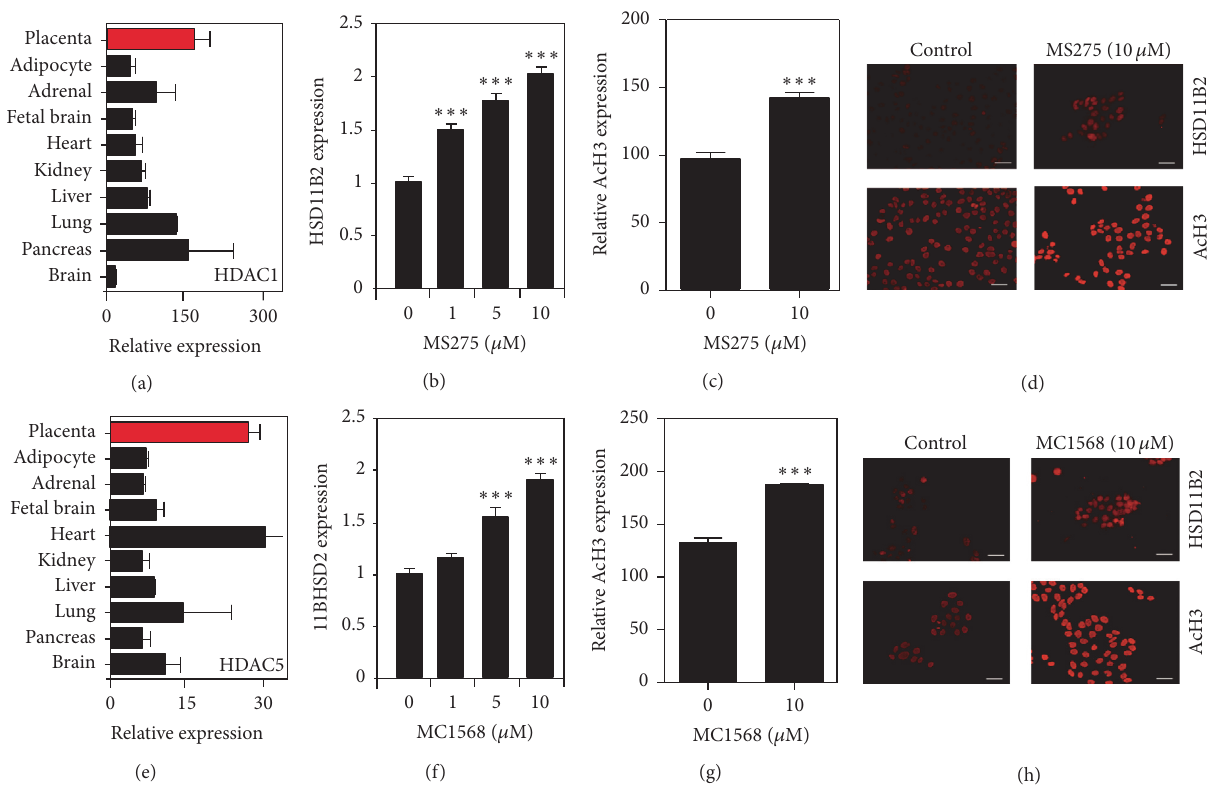
Figure 3: Class-specific HDACs on 11 𝛽 -HSD2 regulation in the placenta. (a) Expression data from the BioGPS database showing the relative expression of class I HDAC, HDAC 1 in the placenta (red) relative to multiple human tissues and fetal brain. Graphical representation of (b) 11 𝛽 -HSD2 and (c) AcH3 expression in JEG-3 cells treated with 0–10 𝜇 M of class I HDAC inhibitor MS275 for 24 h. (d) Representative photomicrographs of JEG-3 cells immunocytochemically stained for 11 𝛽 -HSD2 and AcH3 after treatment with (0–10 𝜇 M) MS275 for 24 h. (e) Expression data from the BioGPS database showing the relative expression of class II HDAC, HDAC 5 in the placenta (red) relative to multiple human tissues and fetal brain. Graphical representation of (f) 11 𝛽 -HSD2 and (g) AcH3 expression in JEG-3 cells treated with 0– 10mM of class IIa HDAC inhibitor MC1568 for 24 h. Data are expressed as mean ± SEM. (h) Representative photomicrographs of JEG-3 cells immunocytochemically stained for 11 𝛽 -HSD2 and AcH3 after treatment with (0–10 𝜇 M) MC1568 for 24 h. Data are expressed as mean ± SEM ( ∗∗∗ 𝑝 < 0.001 compared to 0 𝜇 M; (b, f) one-way ANOVA with post hoc Tukey’s and (c, g) unpaired Student’s 𝑡 -test; 25 cells per group per experiment; 𝑁 = 3 ). Scale bar = 50 𝜇